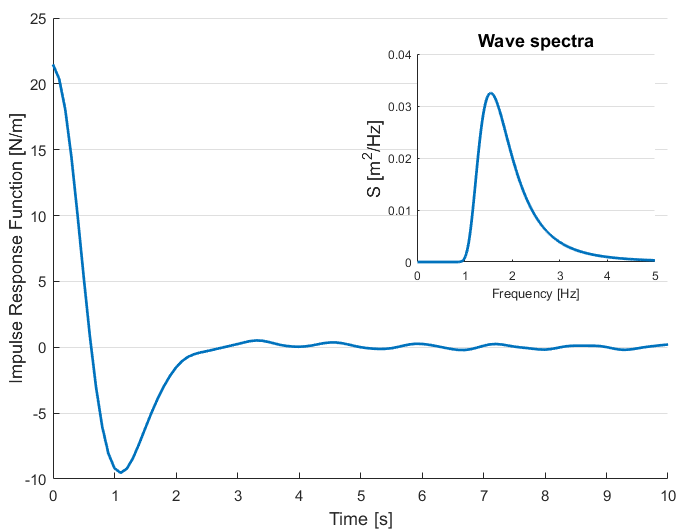
Figure 5. The impulse response function for the radiation force acting on the buoy under the irregular waves of a wave period of 3.5 s and wave height of 0.75 m. The specific wave spectrum is presented in the sub-plot.